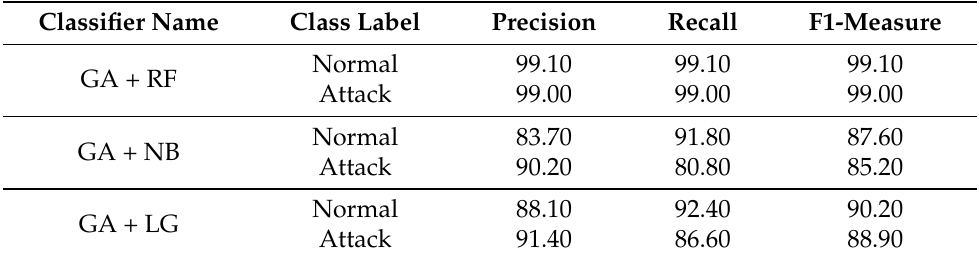
Figure 26. Logistic regression binary class confusion matrix. Table 5. Average classification report comparison of the proposed models.